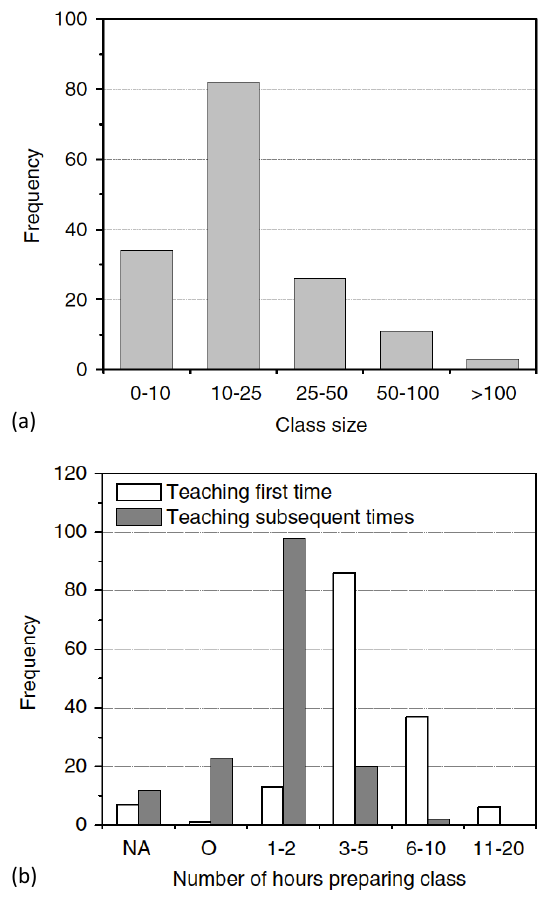
Fig. 1. Survey results showing class sizes and preparation times of hydrology educators (from Wagener et al.,